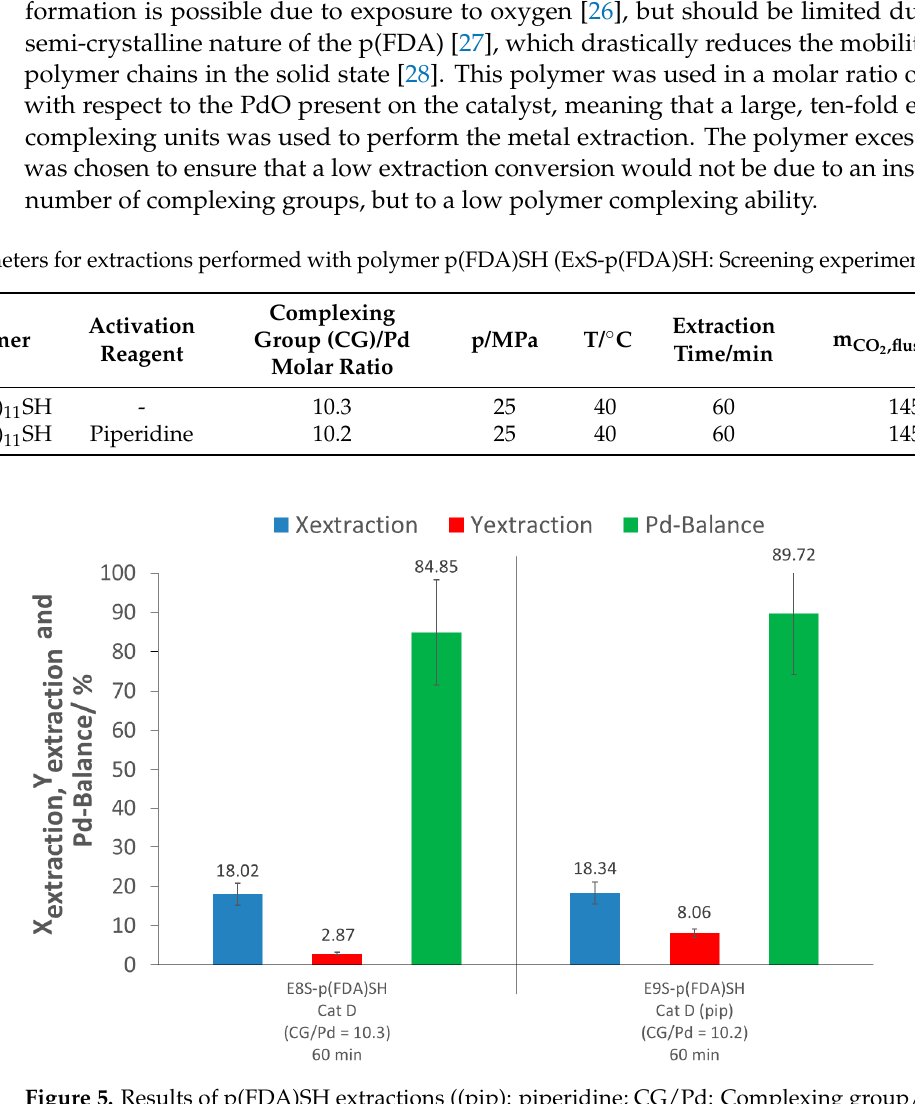
Figure 5. Results of p(FDA)SH extractions ((pip): piperidine; CG/Pd: Complexing group/Pd ratio; ExS-p(FDA)SH: Screening experiments). ExS-p(FDA)SH: Screening